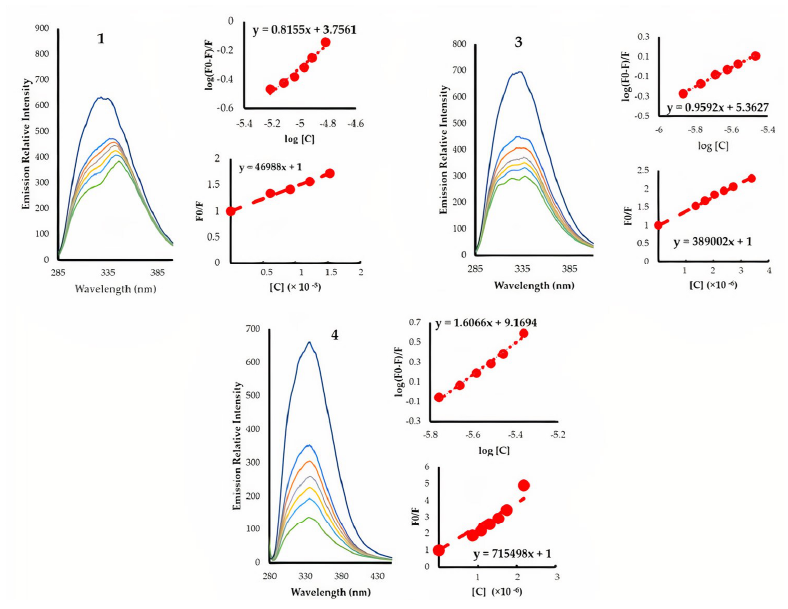
Figure 6. Binding studies of 1, 3 and 4 with HSA. Table 2. Kinetic and thermodynamic parameters of human serum albumin (HSA)-binding at 295 K.